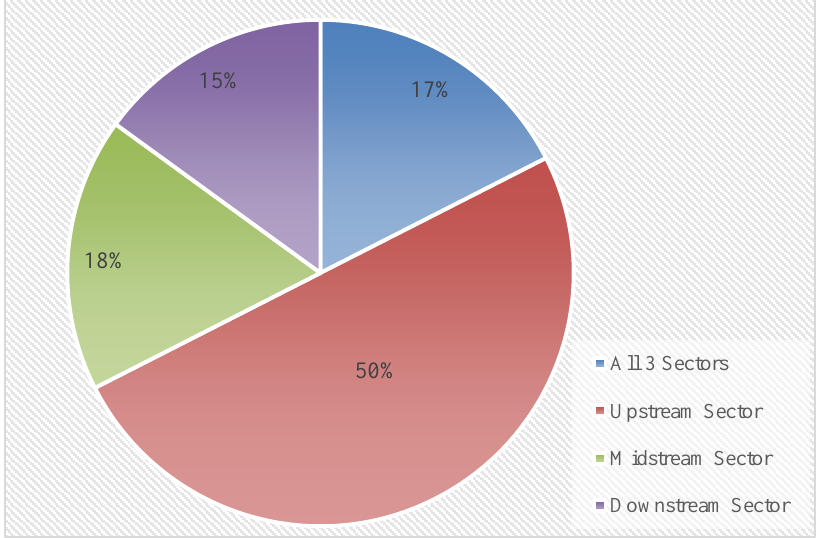
Figure 7. Literature review location focus quantitative